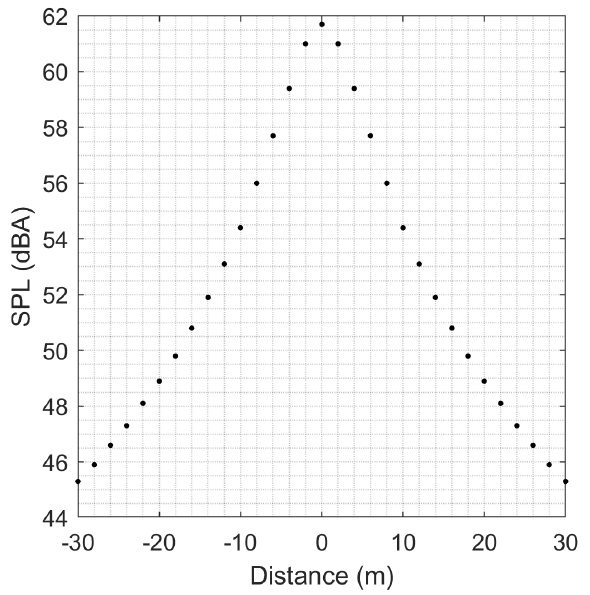
Figure 7. Modelled flyover test (5 m altitude, 90 ◦